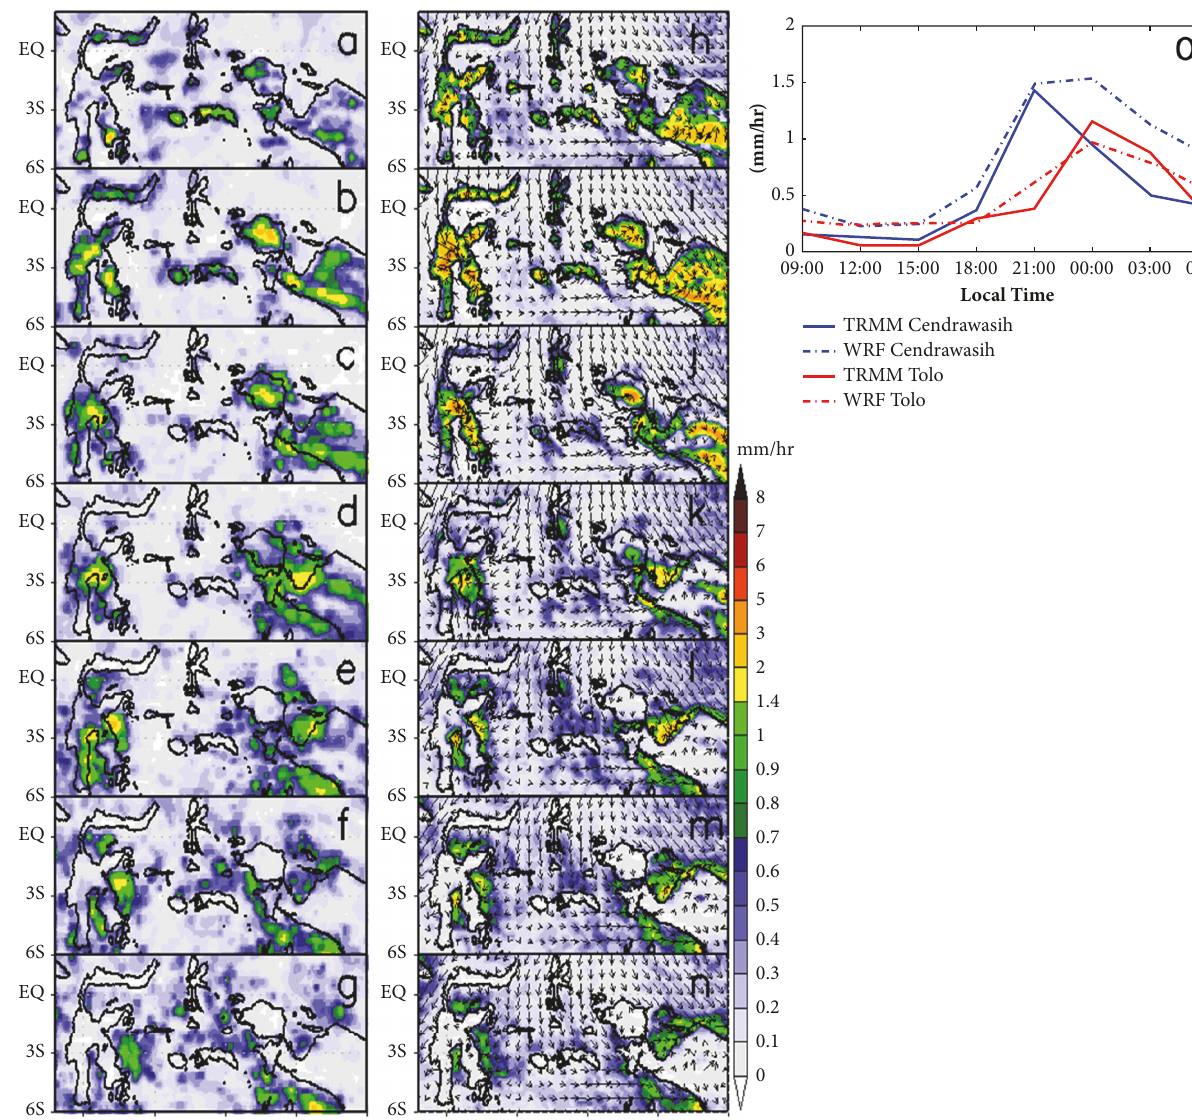
Figure 5: Diurnal rainfall over Maritime Continent based on TRMM 3B42 (left side) during March 2014 with (a) 12LT, (b) 15LT, (c) 18LT, (d) 21LT, (e) 00LT, (f) 03LT, and (g) 06LT. Diurnal rainfall over Maritime Continent based WRF-ARW (right side) during March 2014 with (h) 12LT, (i) 15LT, (j) 18LT, (k) 21LT, (l) 00LT, (m) 03LT, (n) 06LT, and (o) comparison of TRMM and WRF rainfall over Cenderawasih Bay and Tolo